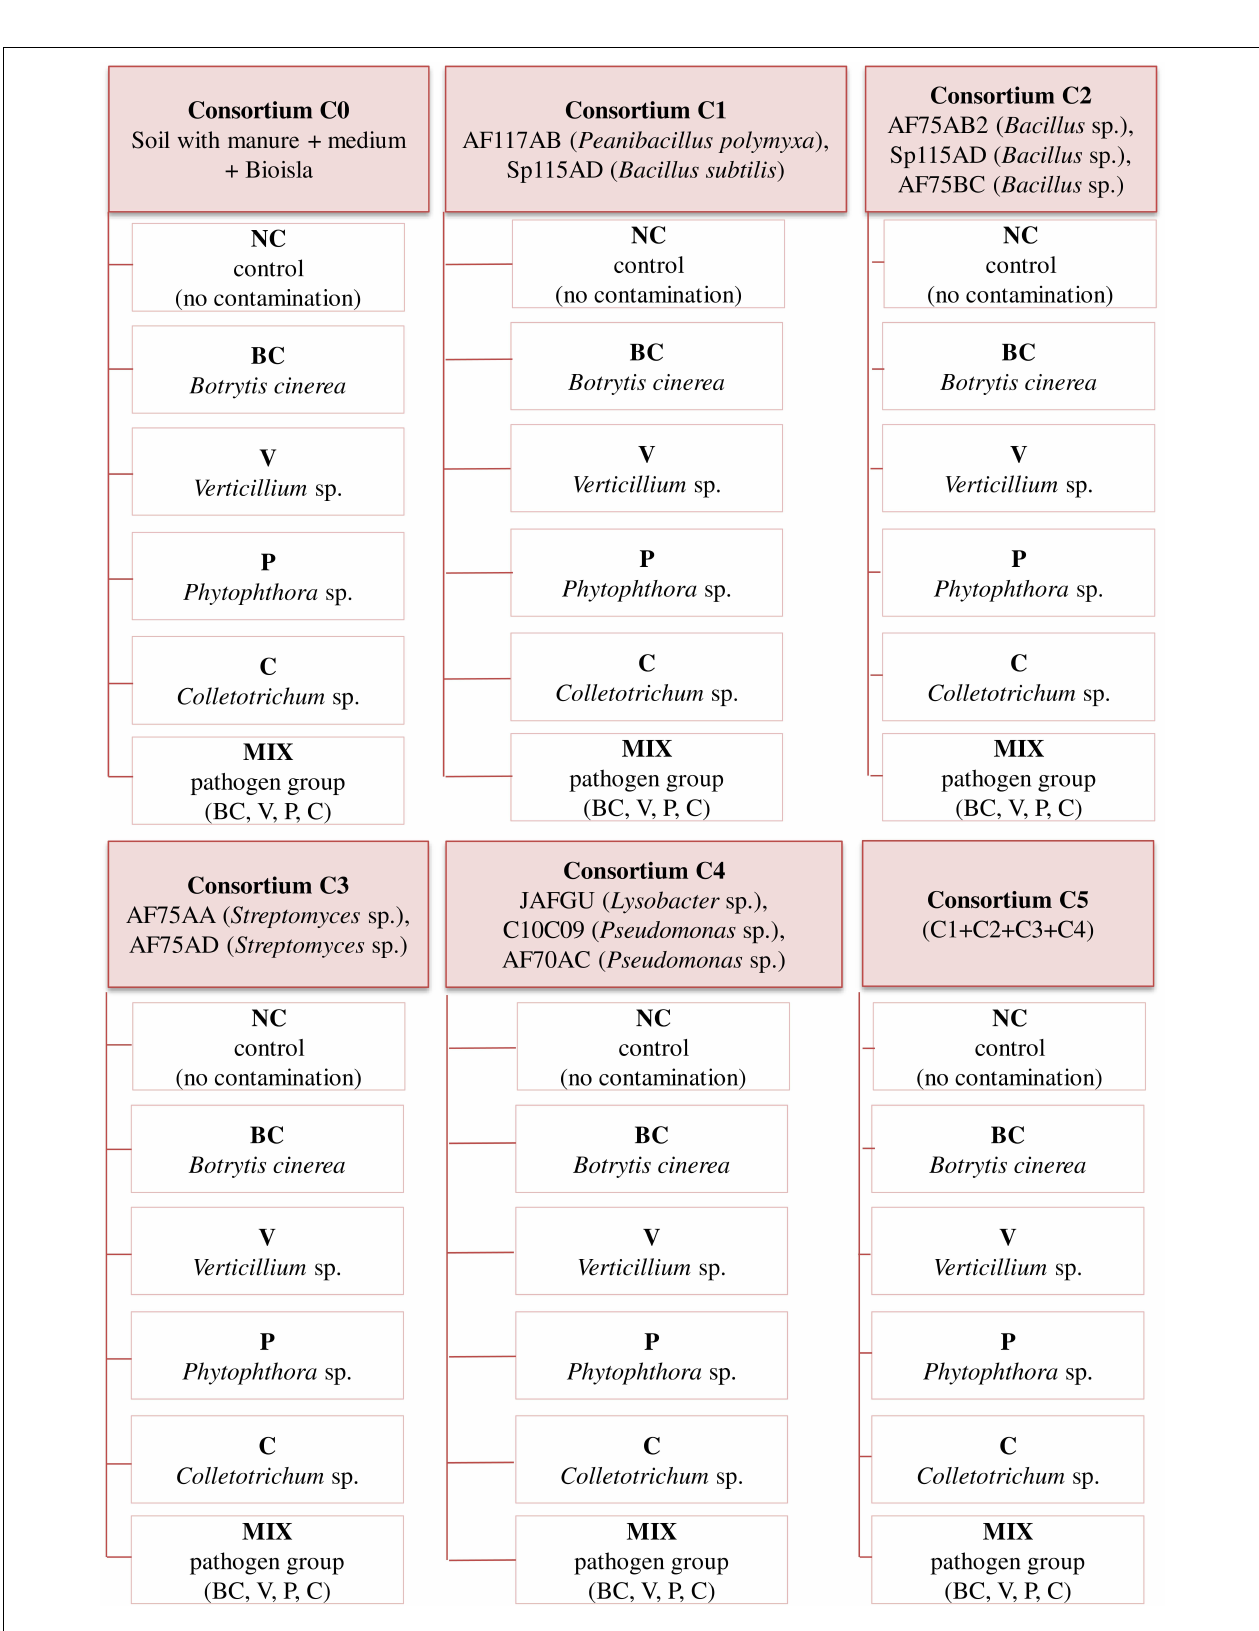
FIGURE 1 | Experimental design outlining 36 variants of the experiment.